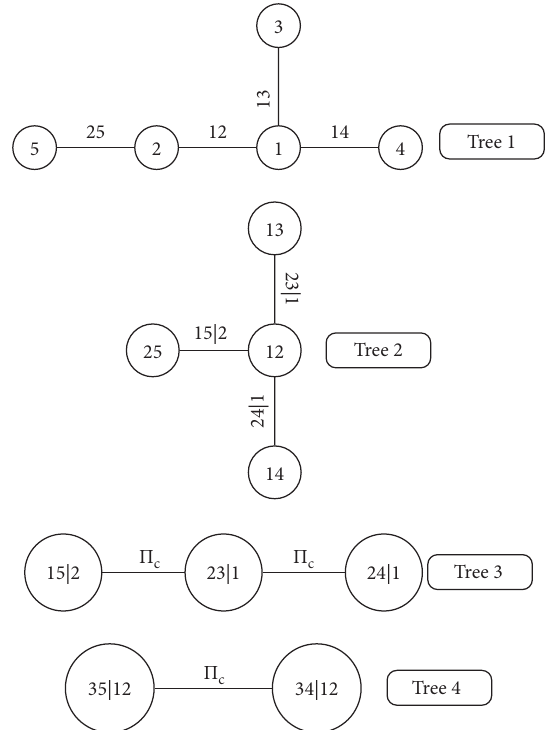
Figure 2: 2-levels truncated R -vine copula mixture model. 5-di- mensional, 4 trees, 7 edges (nonindependent mixture of bivariate copulas and 3 edges (independent bivariate copulas)), and 21